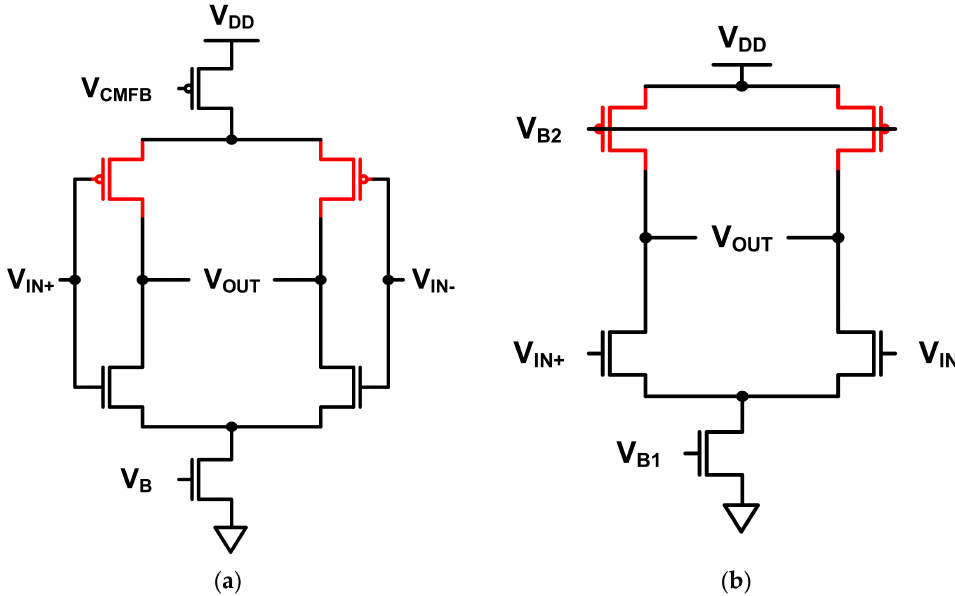
Figure 10. ( a ) Complementary differential amplifier; ( b ) conventional differential amplifier.